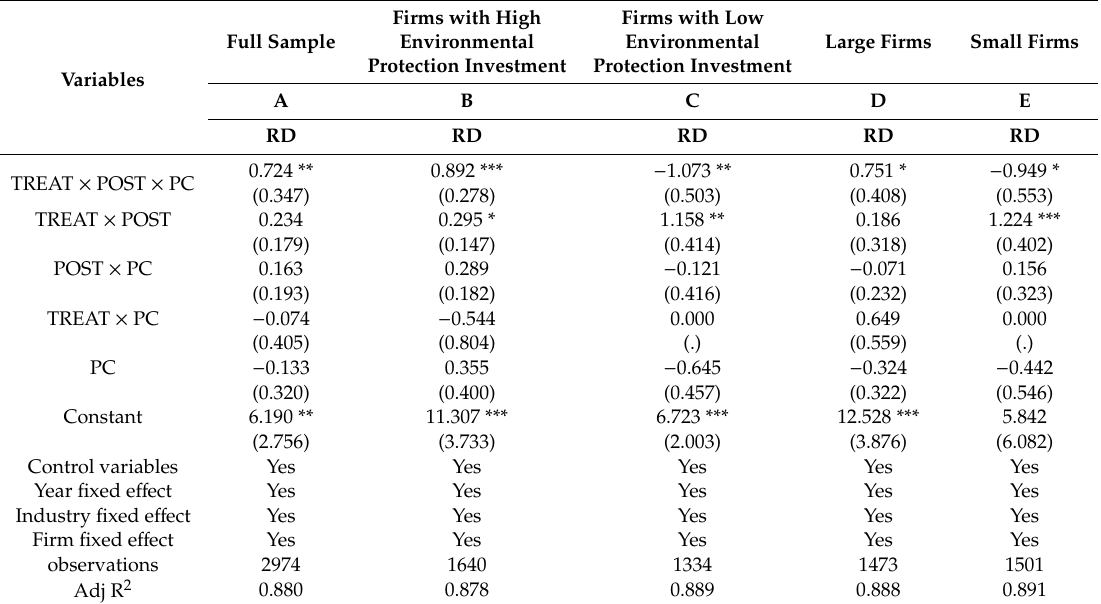
Table 6. Moderating e ff ect of political